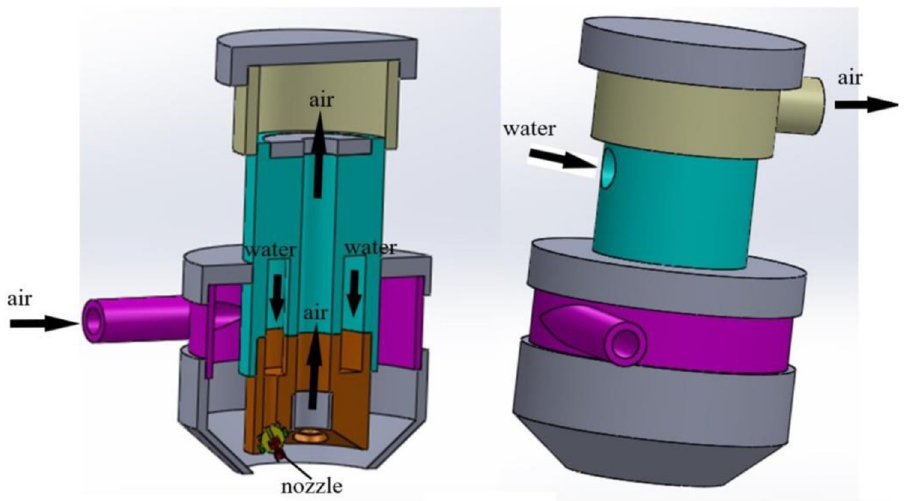
Fig. 3. 3D model of cavitation generating head with water removal